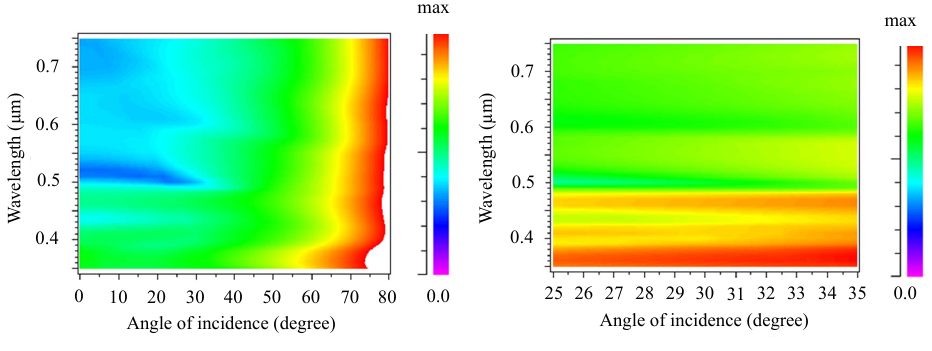
Fig. 6. Reflectances as a function of angle of incident light from visible spectrum for nanostructure with 800 nm period and feature size 200 nm: a – Reflectances for a broad range of angle of incidence; b – Reflectances for a range of angle of incidence corresponding to side